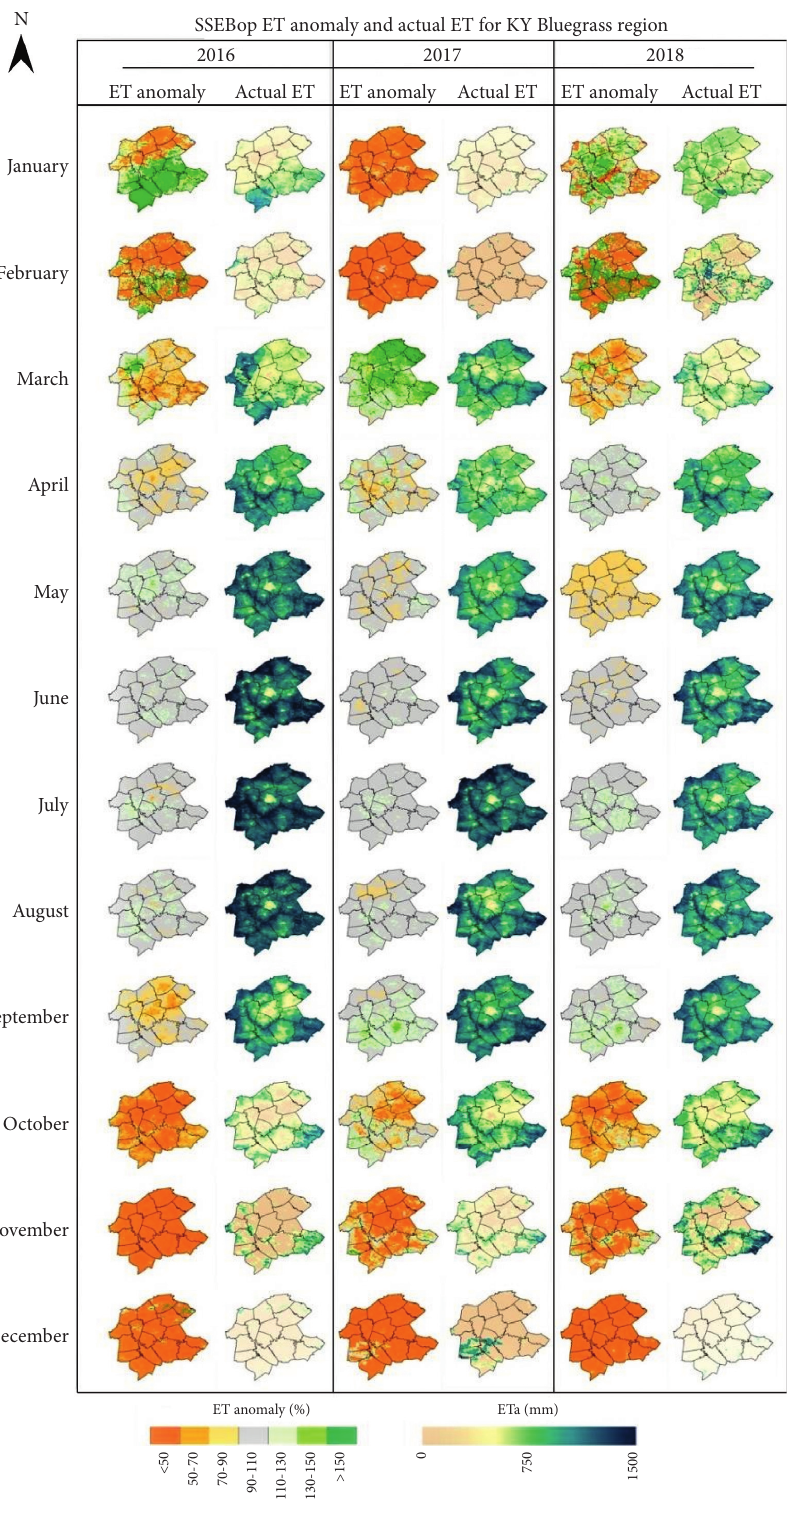
Figure 5: Spatial distribution of the remotely sensed actual ET ( ET a ) and anomalies at the eddy covariance site and surrounding counties from 2016 to 2018. This map includes the 17-county area known as the “Bluegrass” region of Kentucky and they have similar vegetative features, featuring large pastureland and other agricultural lands. The counties are Anderson, Bourbon, Boyle, Clark, Estill, Fayette, Franklin, Garrard, Harrison, Jessamine, Lincoln, Madison, Mercer, Nicholas, Powell, Scott, and Woodford. The area represents 11,070km 2 . Significantly lower than average ET (dry conditions) is identified with orange color. Higher than average ET is identified with green color. Maps showing ETanomalies are shown on the left side of each panel. Anomaly is computed as a deviation between average values of ETof any given year from the historical mean (2000 to